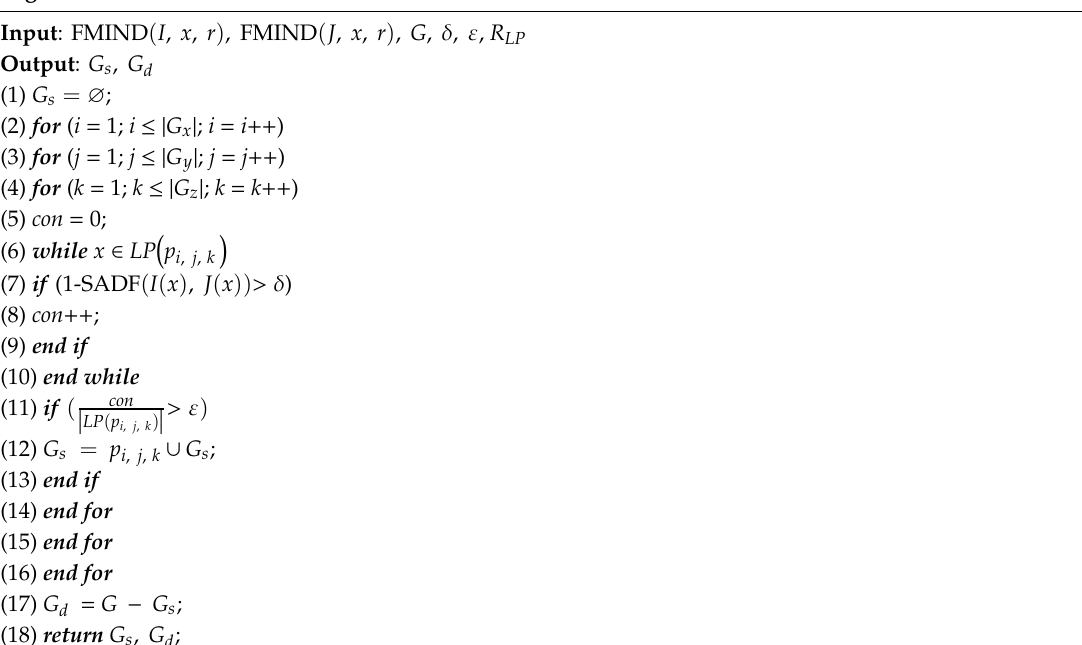
Figure 3. The illustration of the local image block LP ( p i , j , k ) . Algorithm 1. Partition of the vertex set G